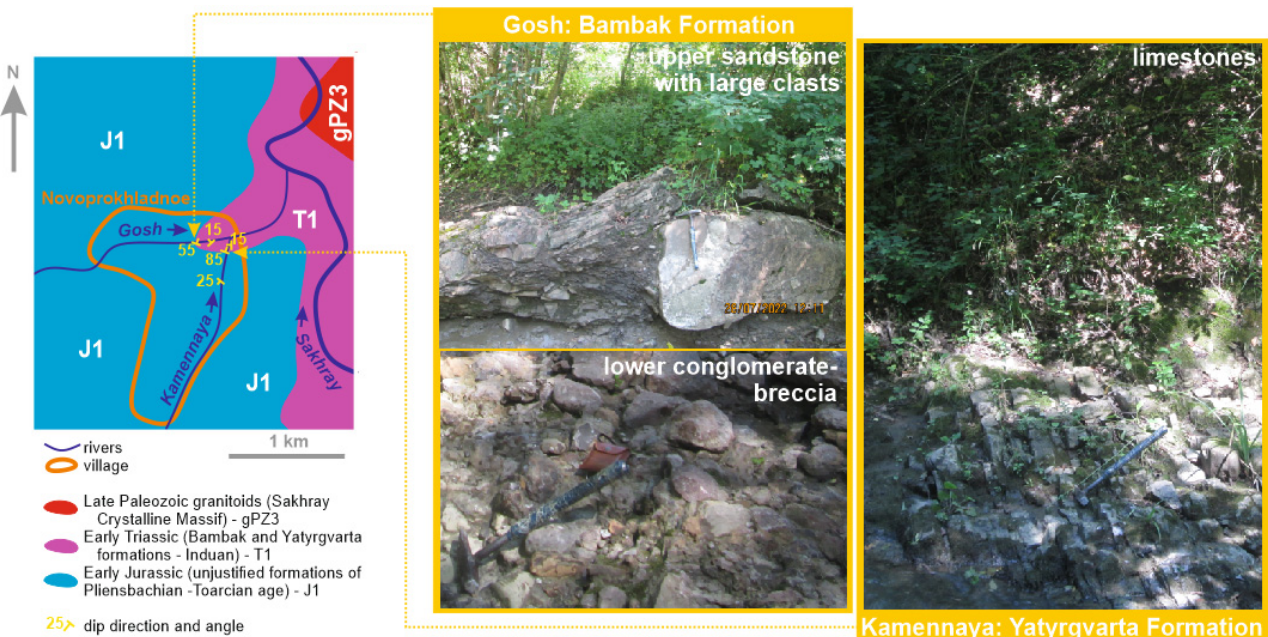
Figure 2. Gosh locality: geological scheme and principal Triassic lithologies (hammer’s length is 40 cm).